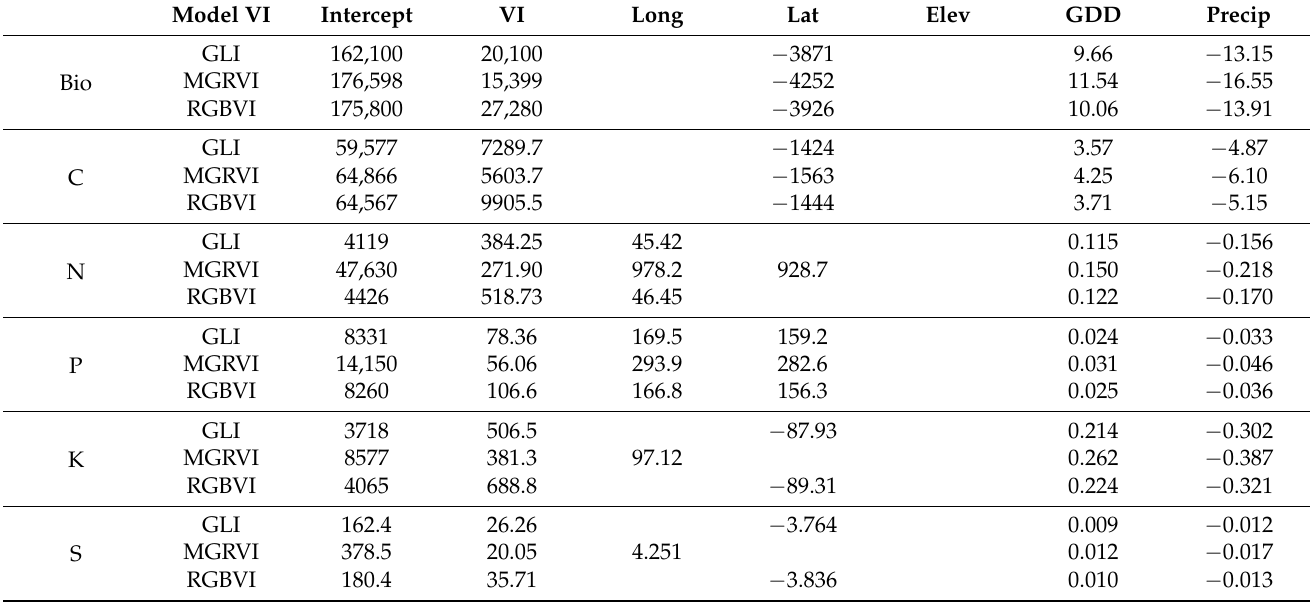
Table 9. Estimated regression coefficients for content-based cereal rye biomass, carbon (C), nitrogen (N), phosphorus (P), potassium (K), and sulfur (S) model parameters determined by forward stepwise multiple linear regression ( α =